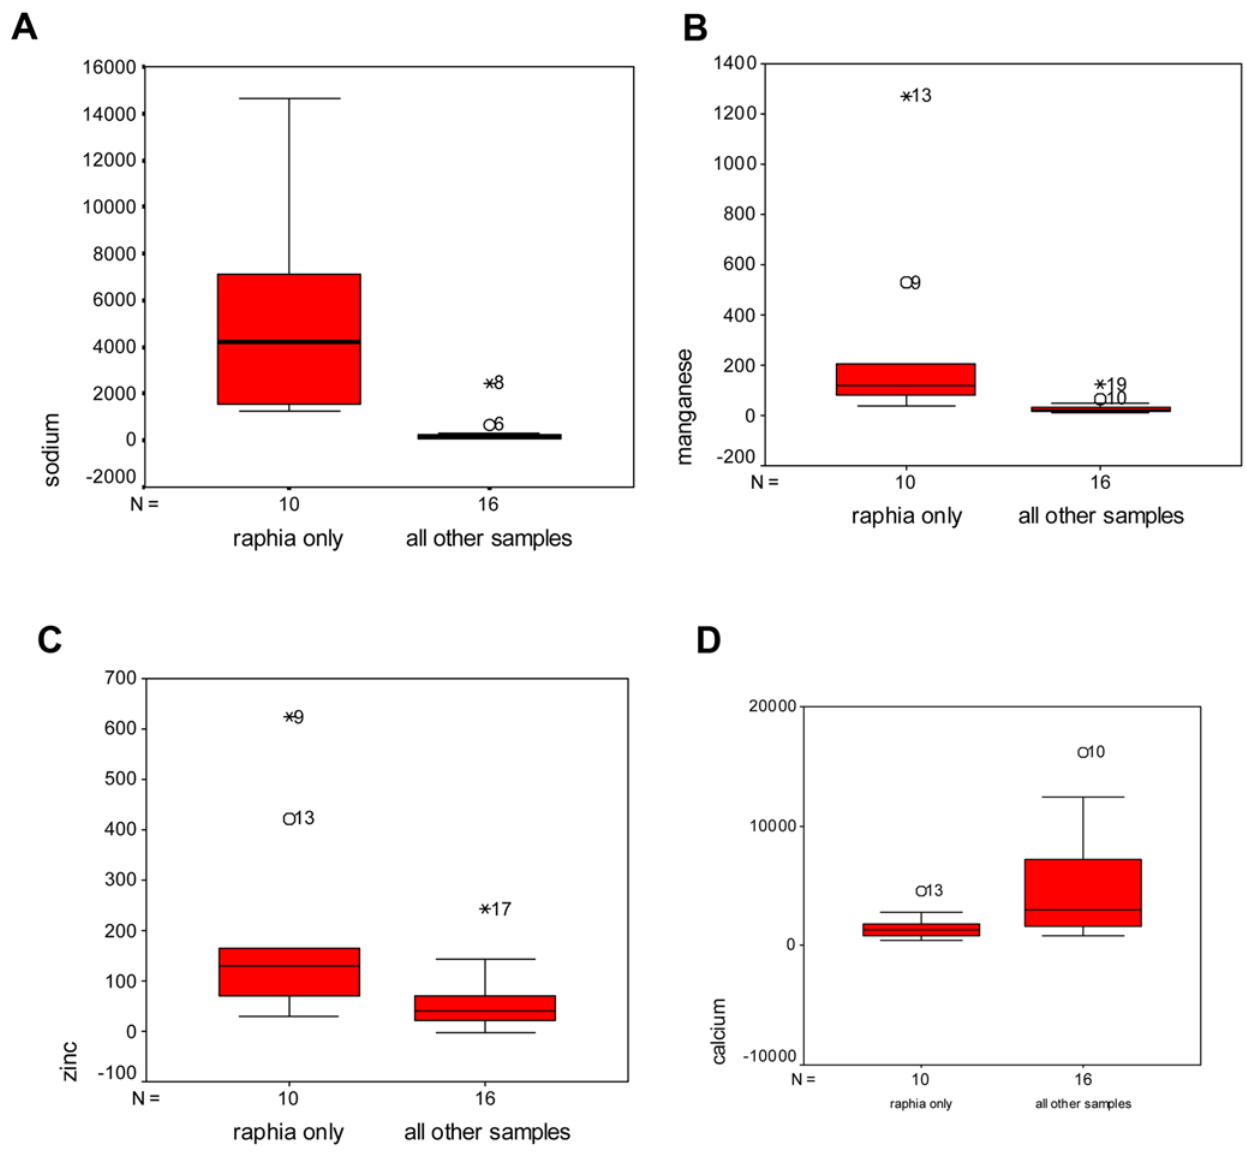
Figure 2. Box plots showing results for raphia samples (without wadge sample) vs all other samples: (a) sodium (b) manganese (c) zinc (d) calcium. All values are mg.kg 2 1 .